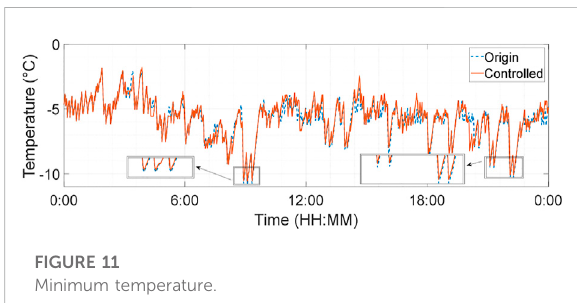
FIGURE 11 Minimum temperature.